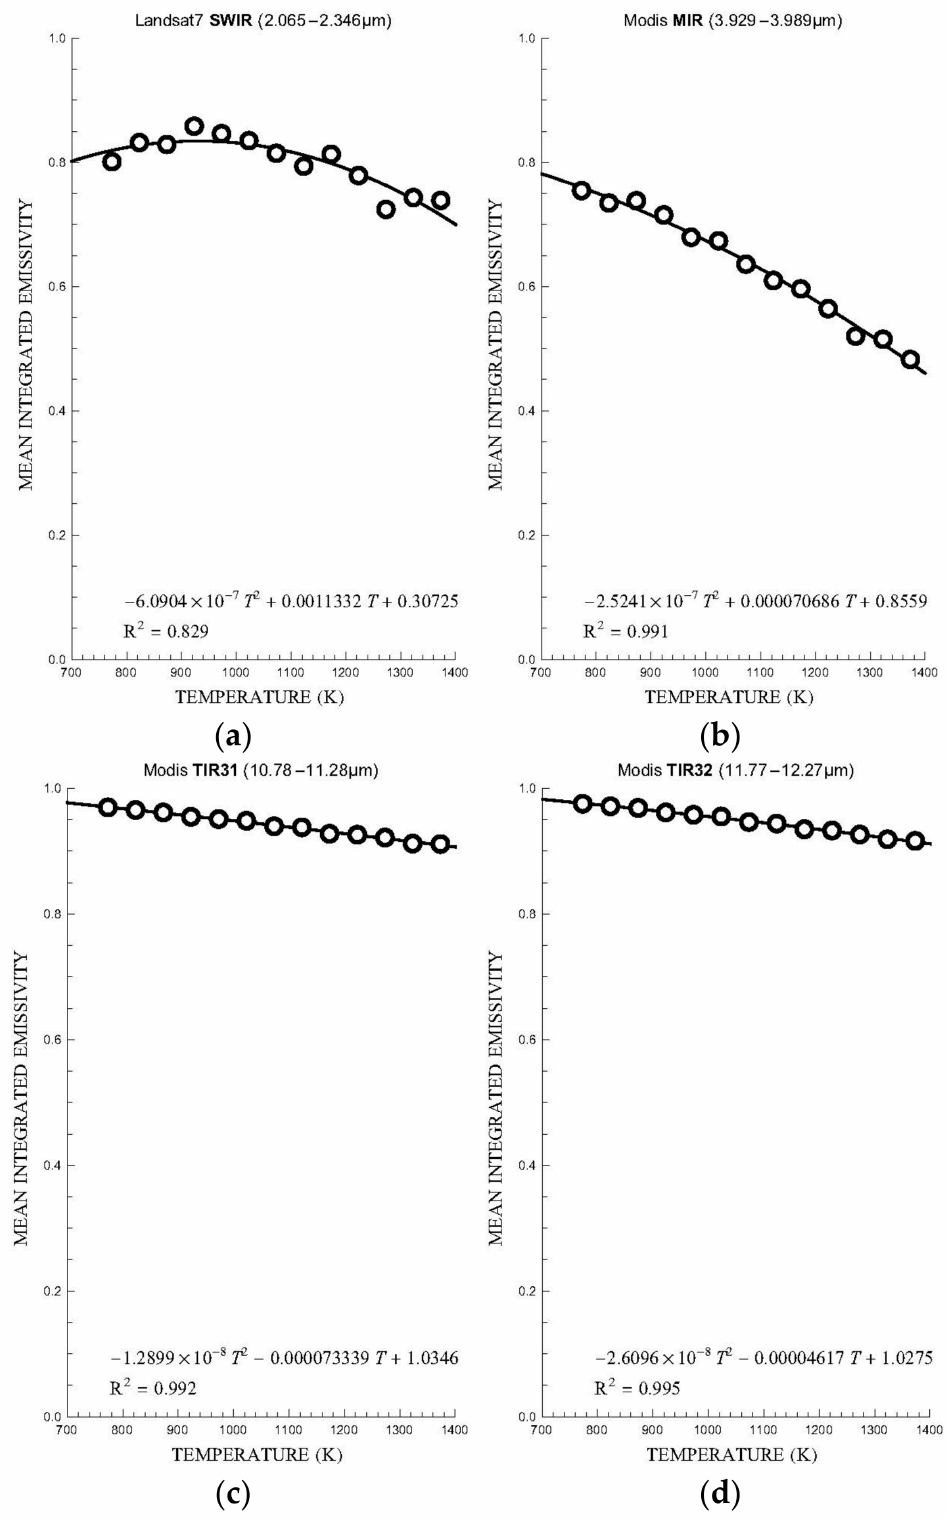
Figure 5. Emissivity–temperature trends at a range of temperatures (773–1373 K) in spaceborne ( a ) SWIR (ETM+) and ( b – d ) MIR-TIR (MODIS)